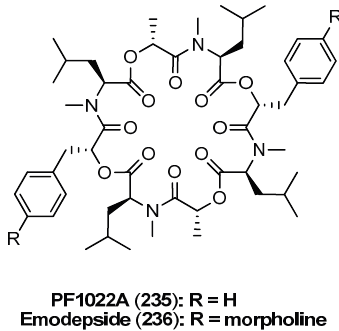
Figure 26. Structures of PF1022A ( 235 ) and emodepside ( 236 ).